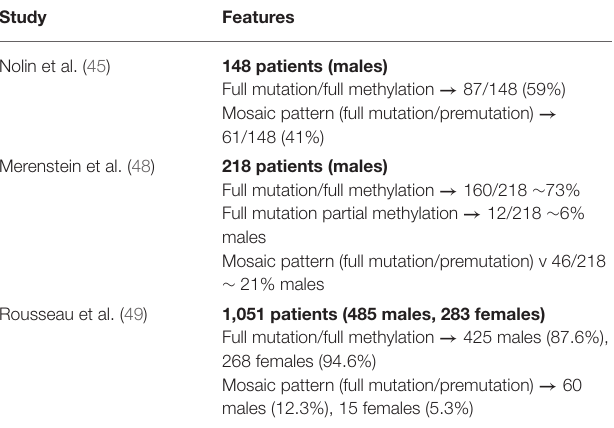
TABLE 3 | Mosaicism features in FXS patient cohorts.